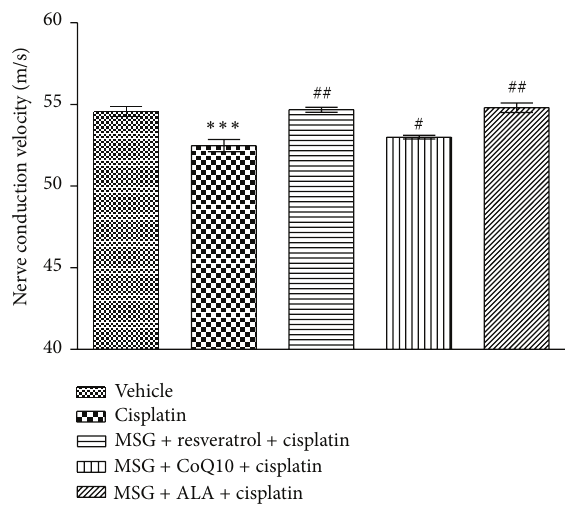
Figure 4: Effect of chronic treatment with combination of MSG and resveratrol/ALA/Co Q10 on grip strength in cisplatin treated rats. ∗∗∗ ( 𝑃 < 0.001 ) versus control group, # ( 𝑃 < 0.05 ), ## ( 𝑃 < 0.01 ) versus cisplatin treated group.